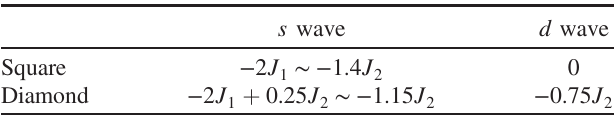
TABLE III. Singlet configuration energy around different plaquettes with different pairing symmetries, estimated from J 1 =J 2 ∼ 0 . 7 for the PVBS phase.